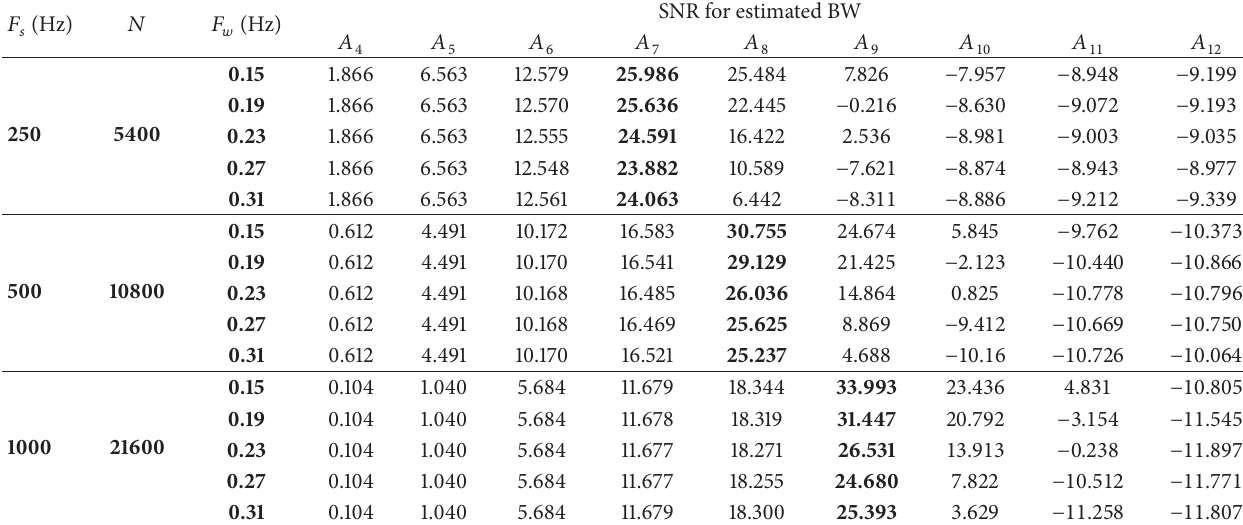
Table 1: BW suppression analysis.